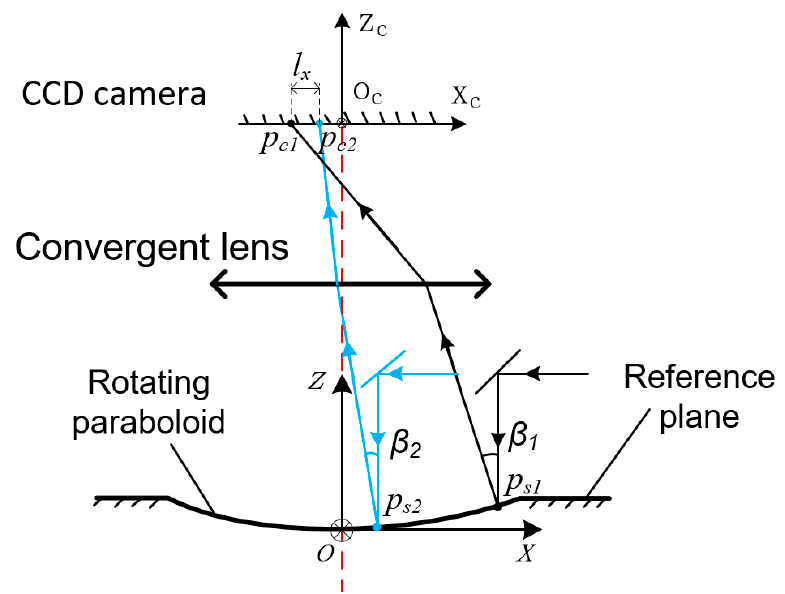
Figure 3. Schematic diagram of relative measurement.